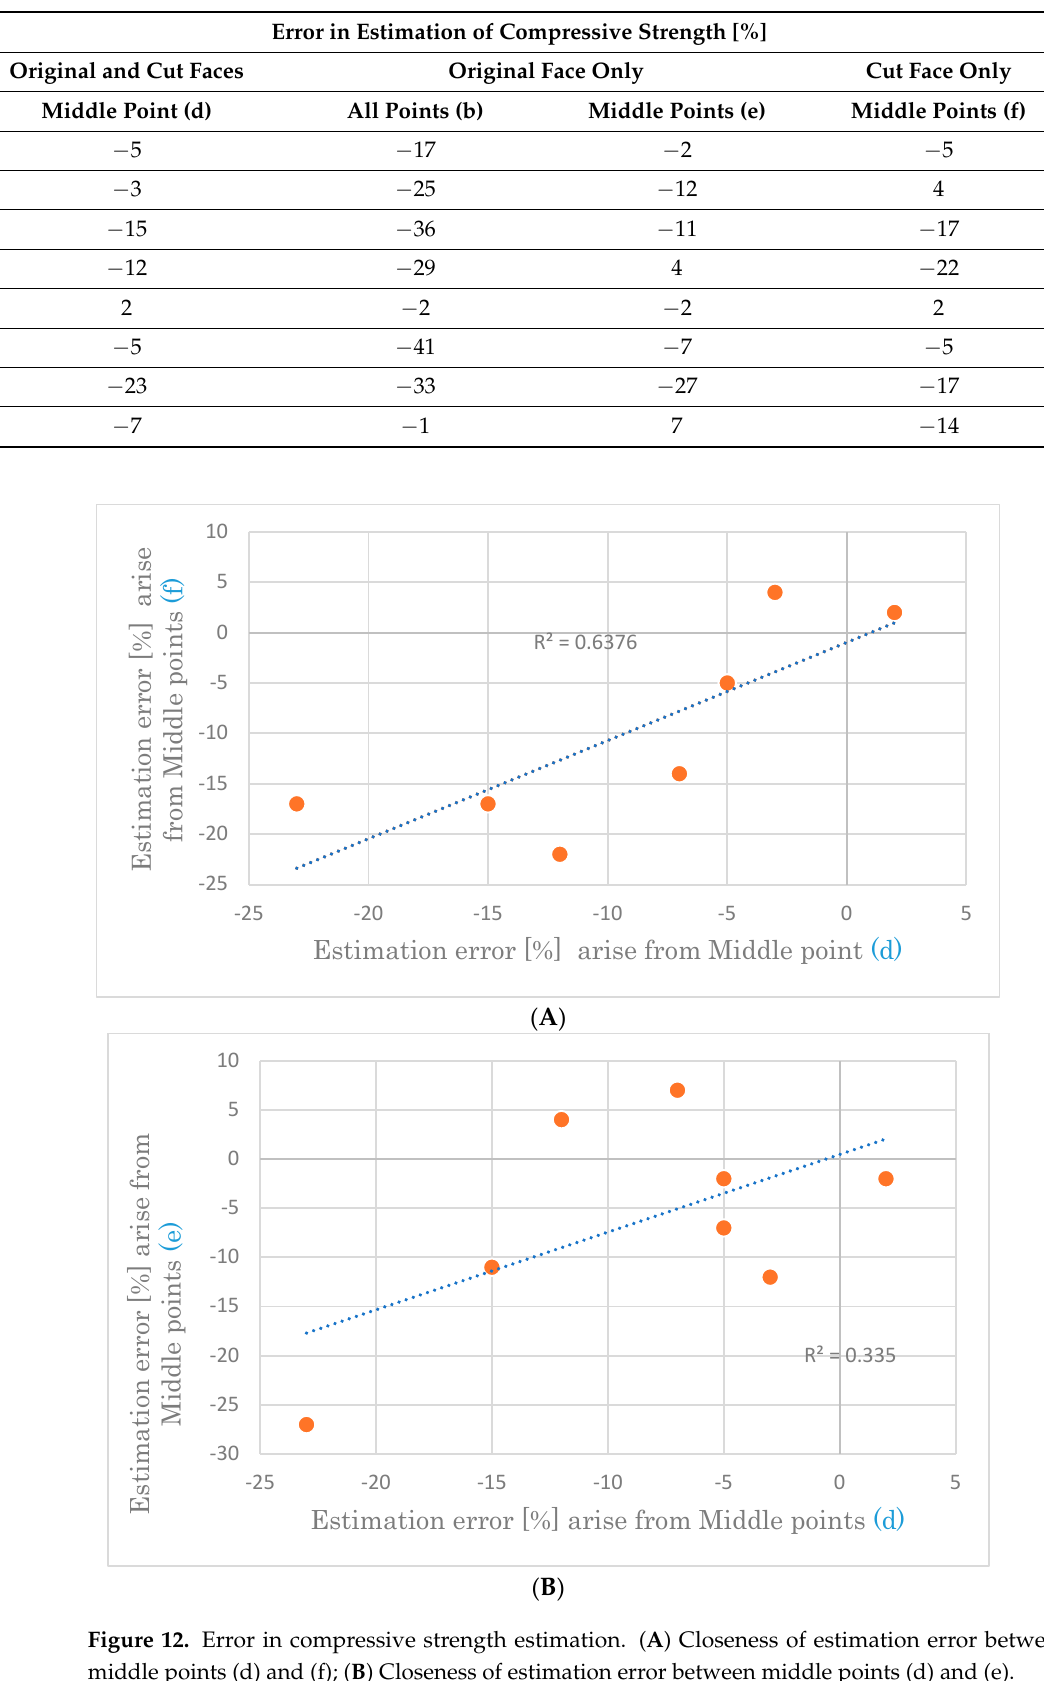
Table 9. Error in estimation of compressive strength.